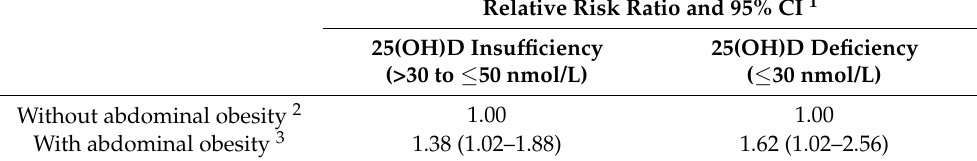
Table 4. Final adjusted model for incidence of serum 25(OH)D insufficiency and deficiency